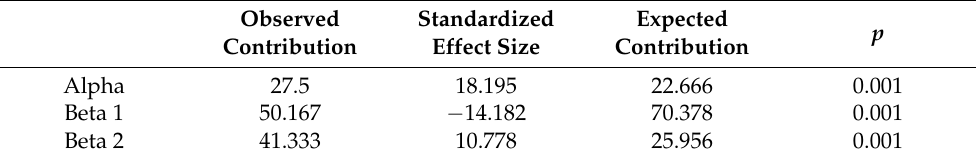
Table 5. Additive diversity partitioning showing the mean contribution of species in each site withing each pond (alpha), variation among sites within each pond (beta 1) and variation among ponds (beta 2). Values for observed and expected by null model are shown, as well as a standardized effect size and p value. Observed Standardized Contribution Effect